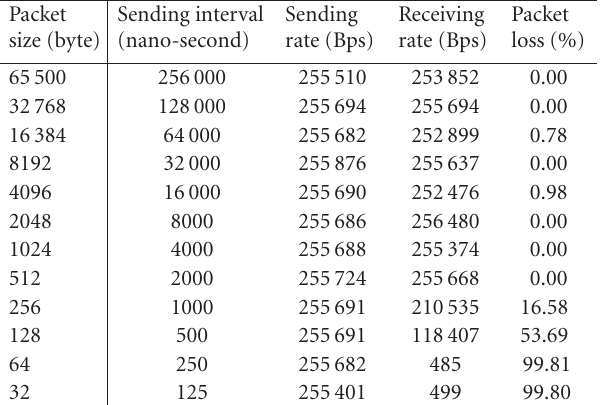
Table 2: E ff ect of di ff erent packet sizes on sending/receiving rate and packet loss (without competing